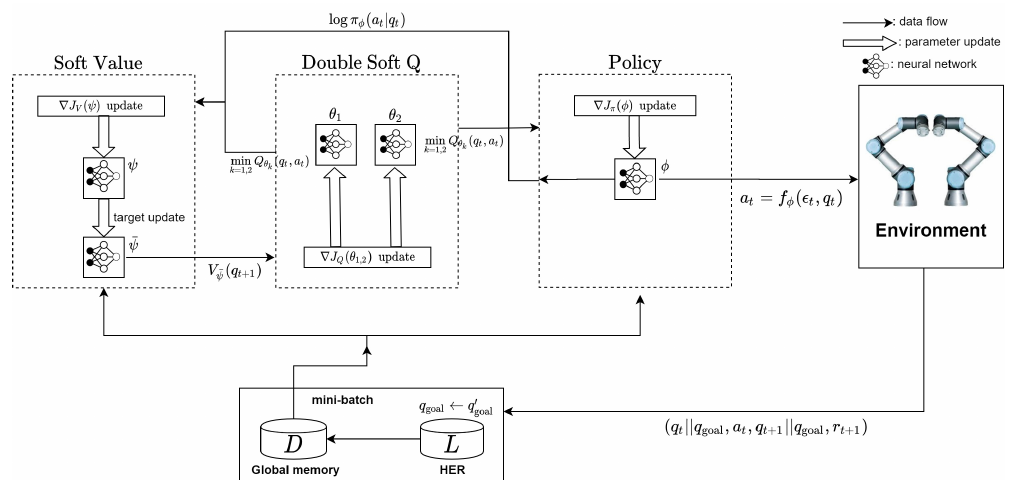
Figure 3. Architecture of the proposed SAC-based path planning algorithm.